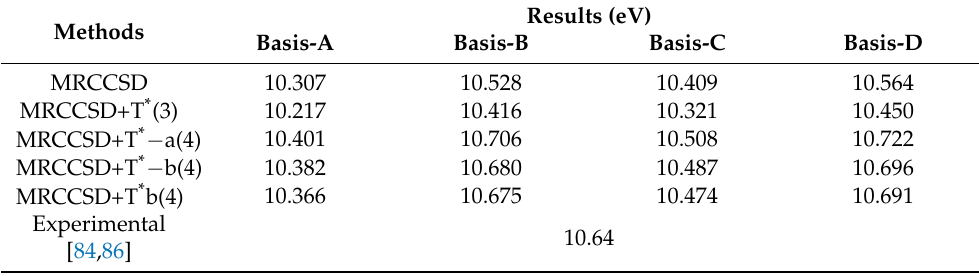
Table 7. Vertical electron affinity of CH + using various basis sets at inter-nuclear separation of 1.12 a. u.